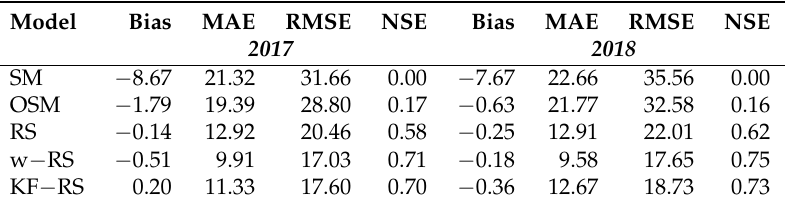
Table 3. Model diagnostic results for intra-day energy demand predictions (hourly) for the years 2017 and 2018.